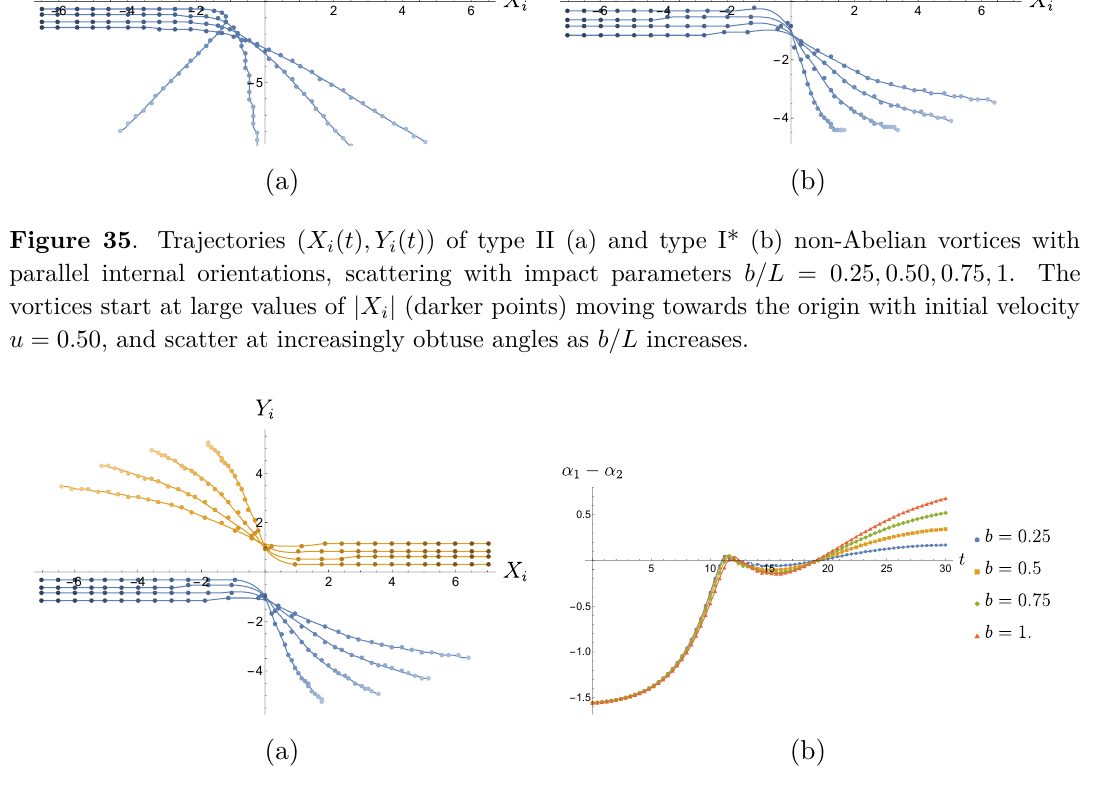
Figure 36 . Scattering of type I* non-Abelian vortices with initially orthogonal internal orientations and impact parameters b/L = 0 . 25 , 0 . 50 , 0 . 75 , 1 . (a) Trajectories ( X i ( t ) , Y i ( t )) of the vortices: starting at large values of | X i | (darker points) and moving towards the origin with initial velocity u = 0 . 50 , they scatter at increasingly obtuse angles as b/L increases. (b) Angle formed between the internal orientations of the vortices during the scattering